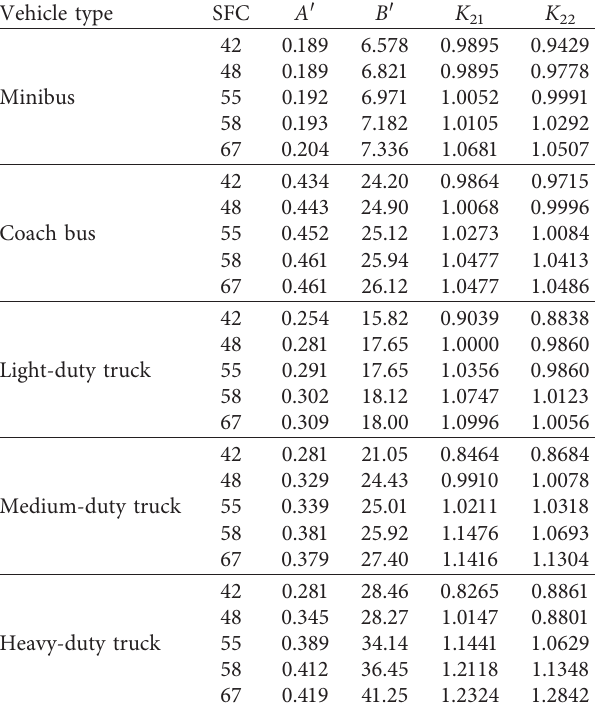
Table 7: Correction parameters based on the friction coefficient SFC.